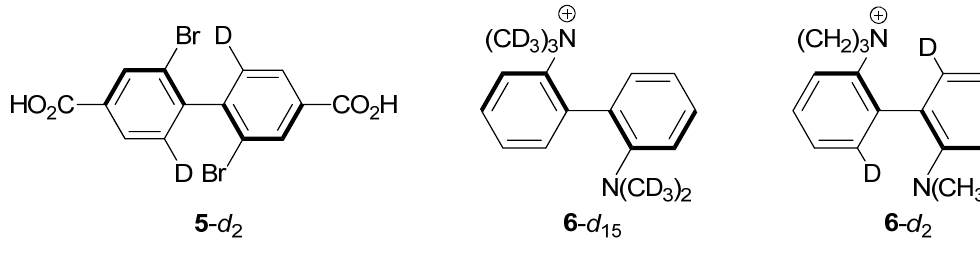
Figure 4. Substituted biphenyl compounds for which CKIEs have been